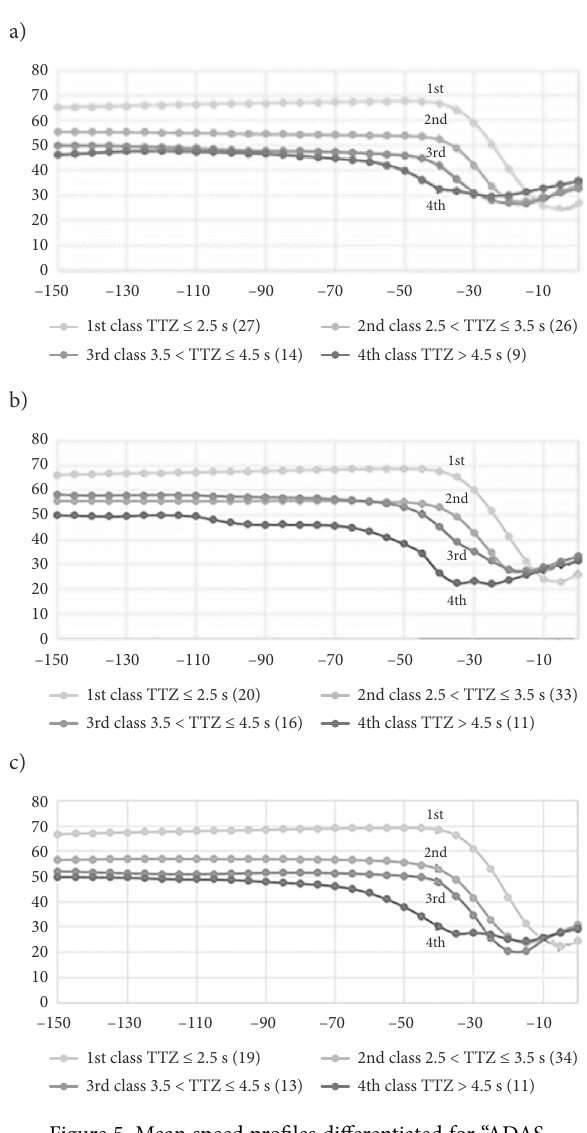
Figure 5. Mean speed profiles differentiated for “ADAS